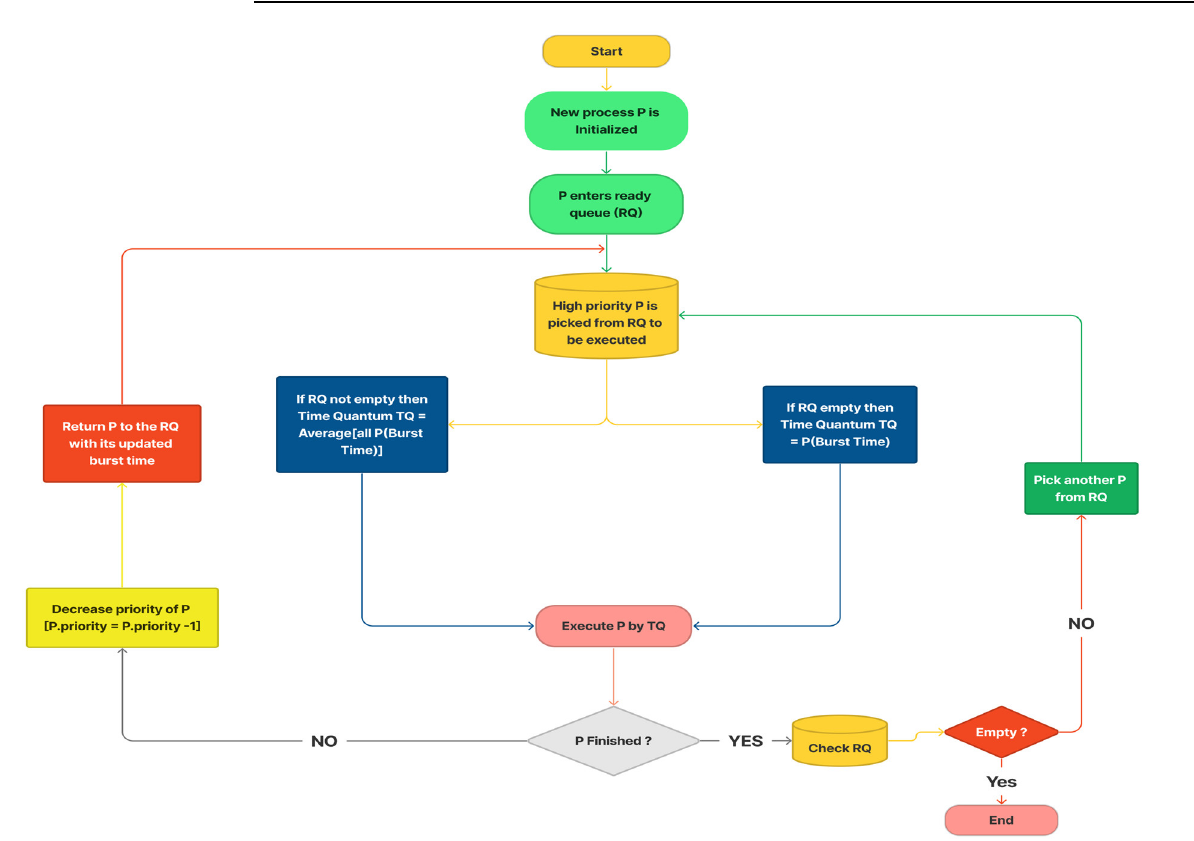
Figure 1. RRAPS algorithm flow chart.